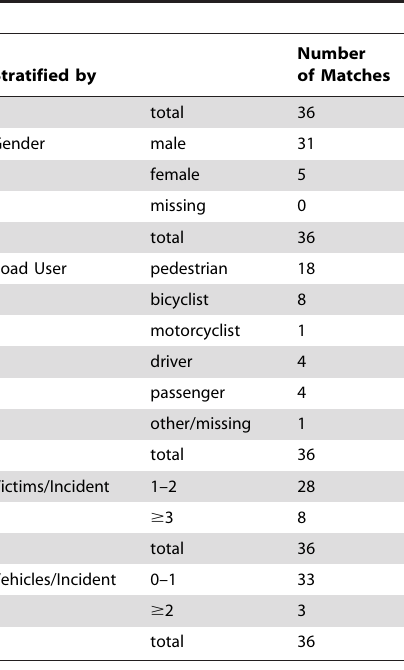
Table 1. Capture-Recapture Estimates of